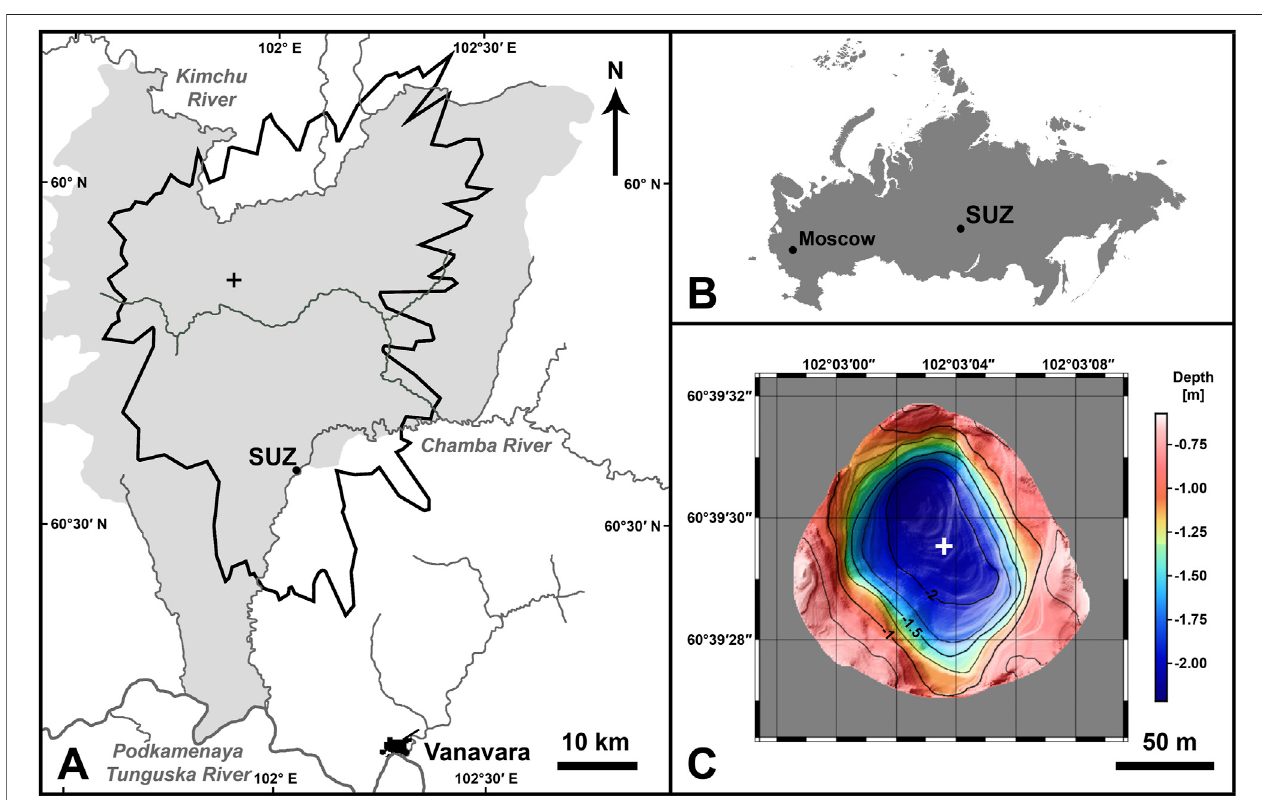
FIGURE1|(A) TheTunguskaregionandthestudysite — SuzdalevoLake(SUZ).TheboldblacklineshowstheborderoftheTEtreefallareatheblackcrossshows the TE epicenter. The area of the Tunguska State Reserve is shown in grey. (B) Geographical location of Suzdalevo Lake within Russia. (C) Bathymetric map of Suzdalevo Lake. The white cross indicates the position where two sediment cores (SUZ1 and SUZ3) were taken.